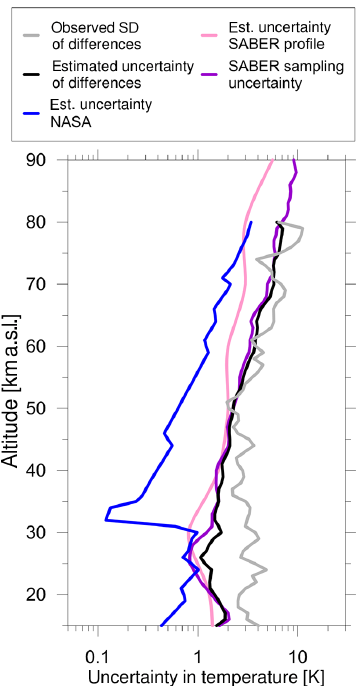
Figure 21. Same as Fig. 20 but for SABER satellite temperature profiles (pink for measurement uncertainty and purple for sam- pling uncertainty) and NASA STROZ (blue for measurement un- certainty). Results for SABER are shown for the weighted aver- age profiles, but very similar results are obtained for closest match SABER profiles. SABER single-profile temperature measurement uncertainty was estimated following Rezac et al. (2015a,